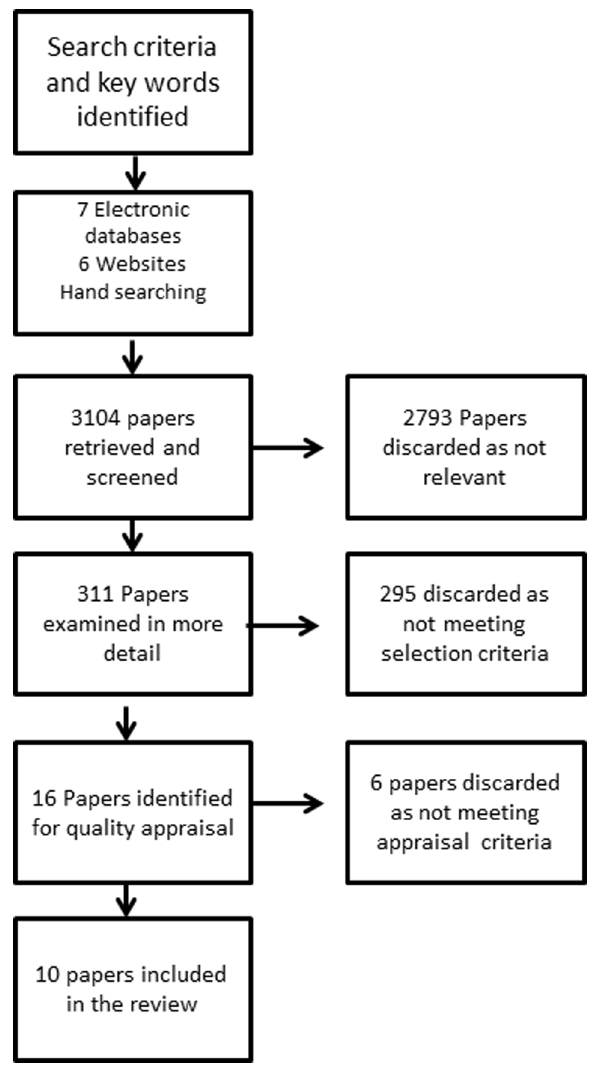
Figure 1. Overview of the literature review process.